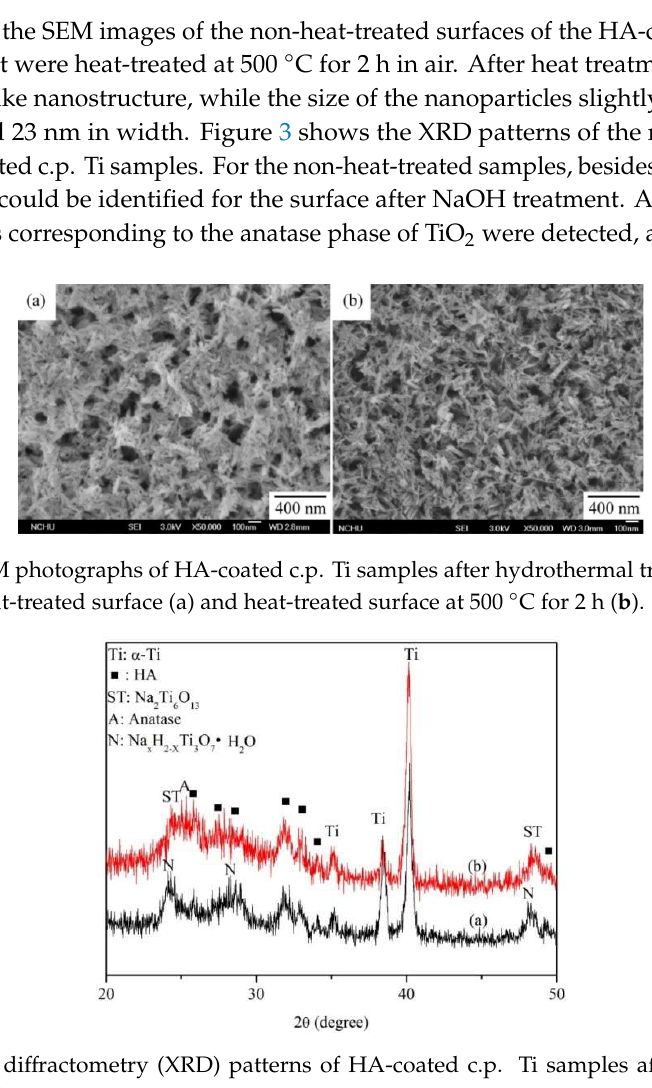
Figure 1. Field-emission scanning electron microscopy (FE-SEM) photographs of the surfaces of commercially pure titanium (c.p. Ti) subjected to hydrothermal treatment at 150 °C for ( a ) 0, ( b ) 12, ( c ) 24, and ( d ) 48 h.